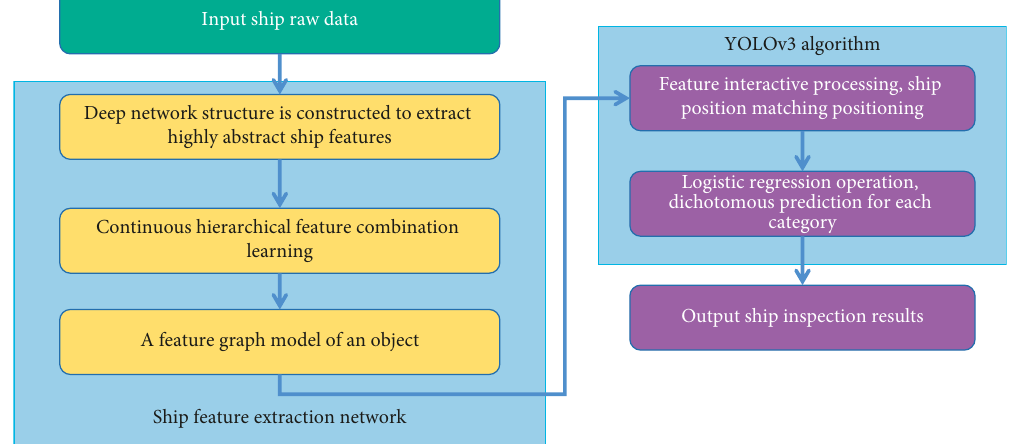
Figure 2: Algorithm flowchart.